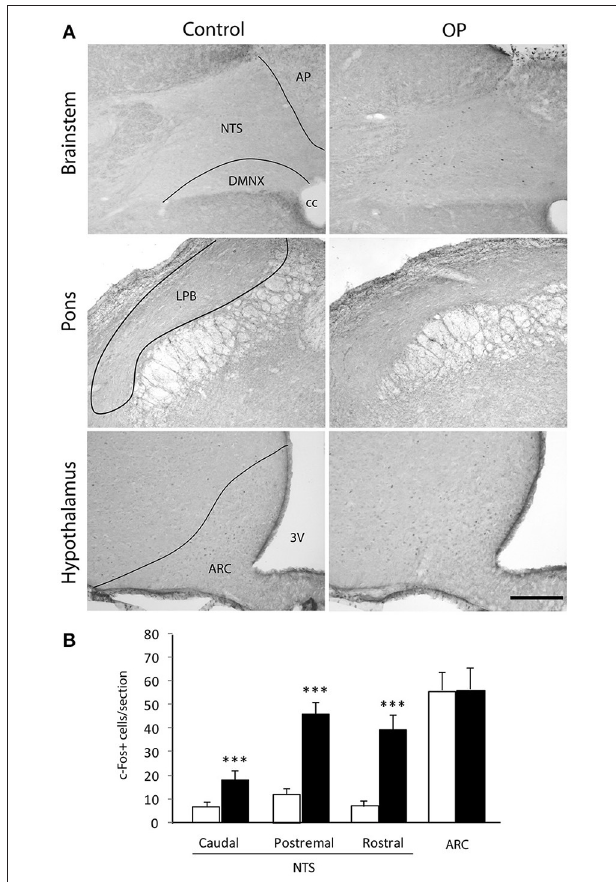
FIGURE 7 | Effects of 4th ventricle OP administration on c-Fos immunoreactivity. (A) Representative coronal sections illustrating the c-Fos labeling observed within brainstem, pons and forebrain regions of mice treated with NaCl 0.9% (left panel) or anorexigenic OP dose (right panel, 2 µ g/rat) and sacrificed 90 min post-treatment. (B) Quantification of the number of c-Fos immunoreactive nuclei within brainstem, pons and forebrain nuclei observed in mice treated either with vehicle (NaCl 0.9%, white bars) or OP (2 µ g/rat, black bars). *** P < 0.001 significantly different from vehicle-treated rats. Scale bar: 150 µ m. 3V, third ventricle, AP, area postrema; ARC, arcuate nucleus; cc, central canal; LPB, lateral parabrachial nucleus; NTS, nucleus tractus solitarius; DMNX, dorsal motor nucleus of the vagus.